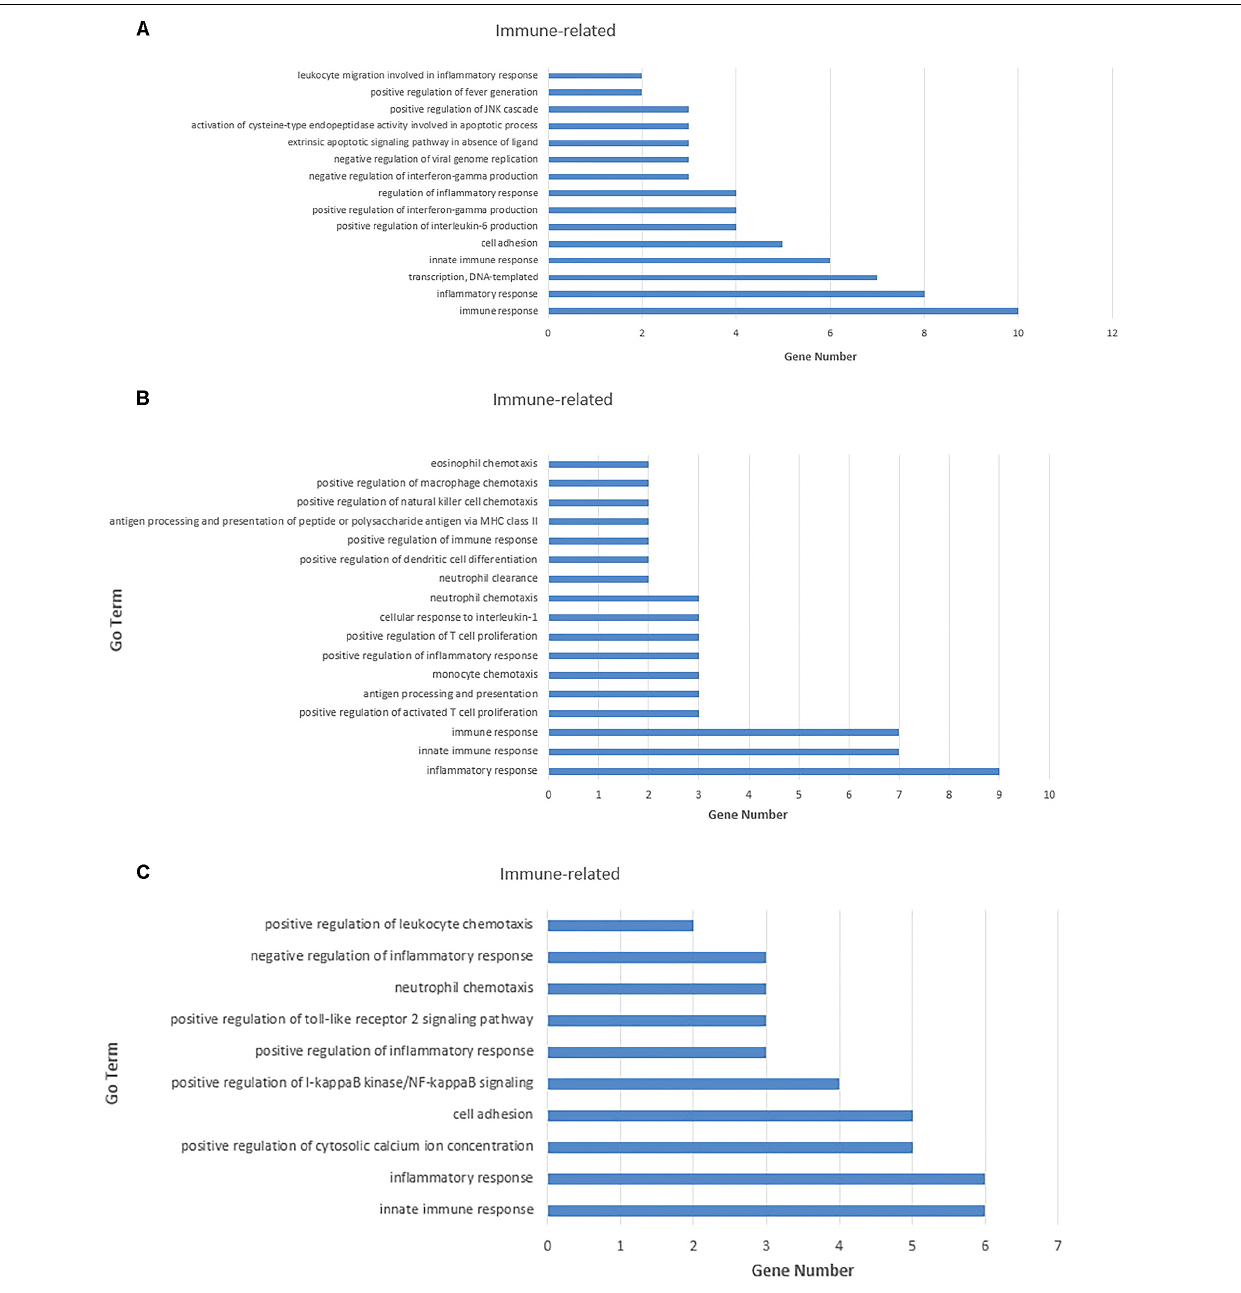
FIGURE 7 | Gene ontology (GO) enrichment analysis for negatively correlated miRNA–mRNA. (A) Enriched immune-related GO terms of 109 target genes of repressed DE miRNAs in the lung tissue. (B) Enriched immune-related GO terms of 135 target genes of repressed DE miRNAs in the trachea tissue. (C) Enriched immune-related GO terms of 141 target genes of repressed DE miRNAs under the infected state with different tissues. The abscissa represents the sample name, and the numbers indicate related